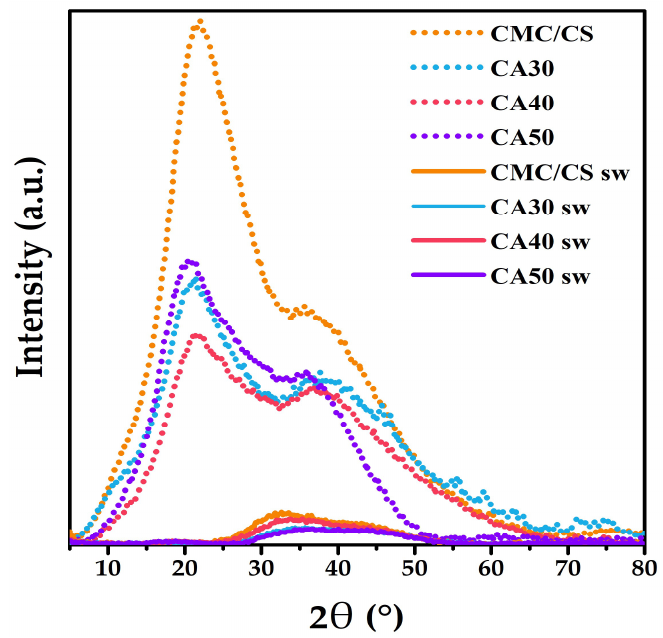
Figure 4. XRD patterns of the CMC-CS and CMC-CS sw hydrogels at different CA proportions.